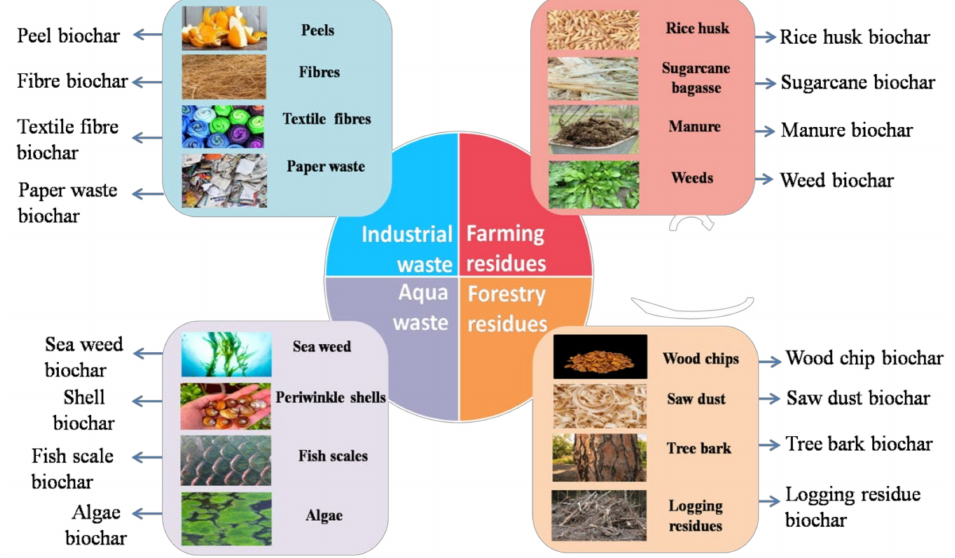
Figure 1. Different sources of raw materials and types of